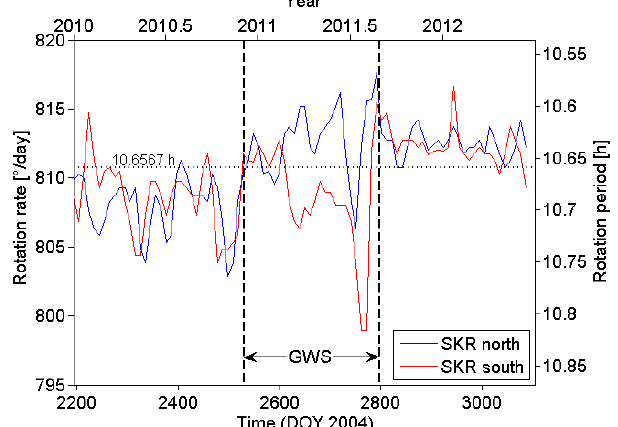
Figure 7. Phase difference and rotation rate difference of northern to southern SKR as a function of time over 2.5 years from the be- ginning of 2010 until the middle of 2012. The SKR phase difference (northern phase minus southern phase) is plotted as a blue line and refers to the left (blue) vertical axis. The SKR rotation rate differ- ence (northern minus southern rate) is plotted as a red line and refers to the right (red) vertical axis. The time is given in days of year 2004 at the bottom horizontal axis and in years at the top horizontal axis. The time of the Great White Spot (GWS) event lasting from 5 De- cember 2010 to 28 August 2011 is indicated. A vertical dotted line was inserted on day 2610 (22 February 2011) to indicate the start- ing SKR phase and rotation rate differences, and another one was inserted on day 2728 (20 June 2011) marking the date of the GWS head–vortex collision, which resulted in reduced convective activ-